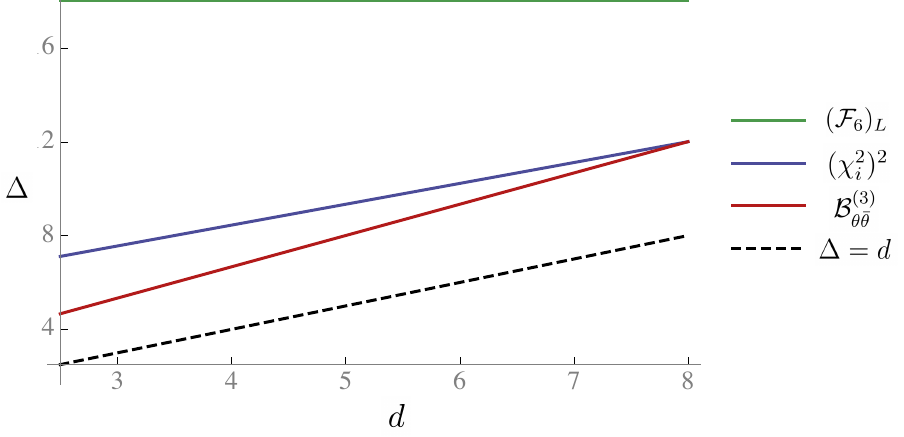
Figure 2 . Plot showing dimensions of the lowest dangerous leaders from the three categories vs spacetime dimension d